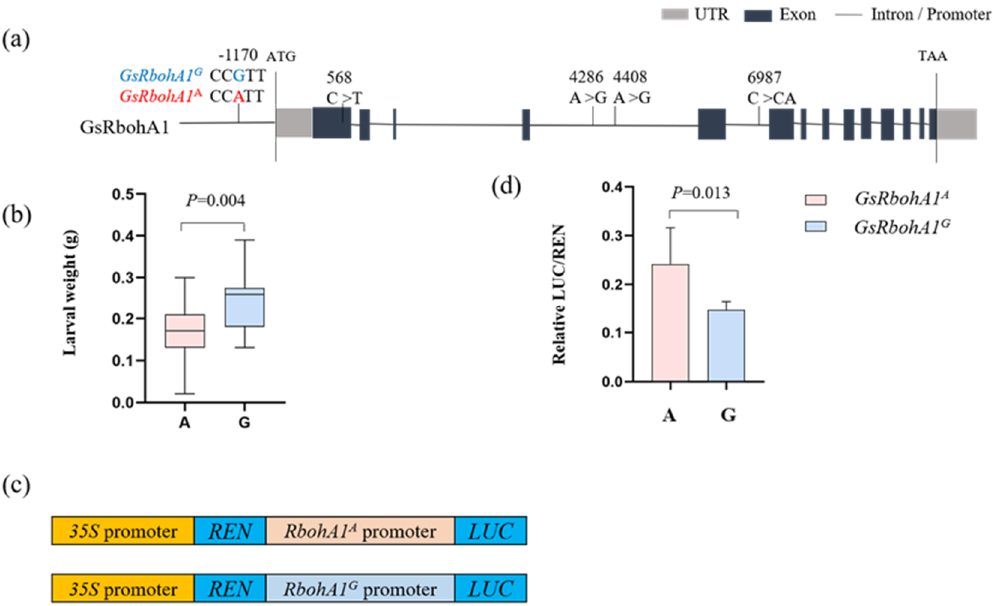
Figure 6. Resistance haplotype GsRbohA1 A has stronger transcriptional activity than GsRbohA1 G . ( a ) Structural variations of GsRbohA1 in the wild soybean population used in this study. The position number starts counting at ATG, including the intron region. ( b ) The larval weight distribution of GsRbohA1 A and GsRbohA1 G haplotypes. ( c ) Constructs used for the transient transfection assay. ( d ) Luciferase activity under the control of the promoters GsRbohA1 A and GsRbohA1 G , respectively. The error bars represent the standard deviations, n = 4; statistical significance was detected by a two-tailed t -test. Two independent assays showed similar results.